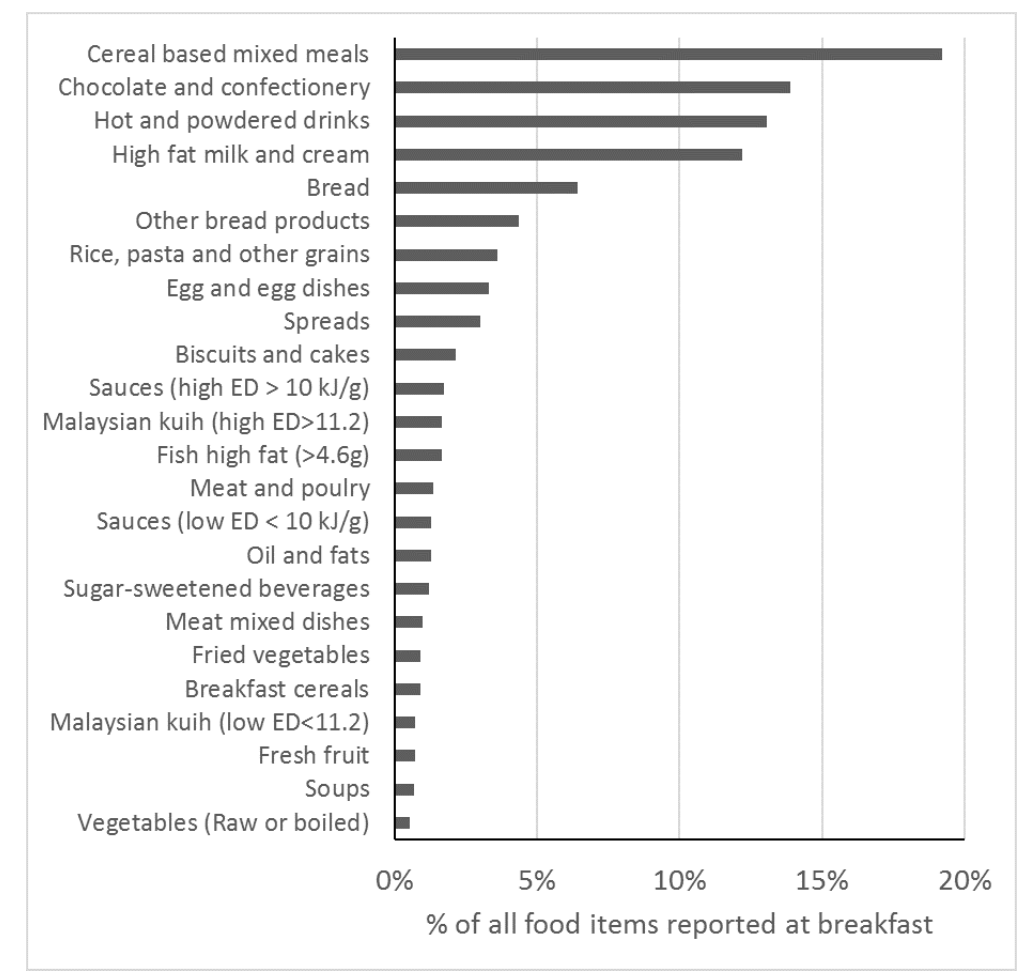
Figure 3. Food groups eaten for breakfast. Bars represent percentage of each food group from all food items reported in breakfast occasions ( n = 15,507 food items reported at breakfast). Only food groups contributing 1% or more to all food items are displayed. Energy density (ED).